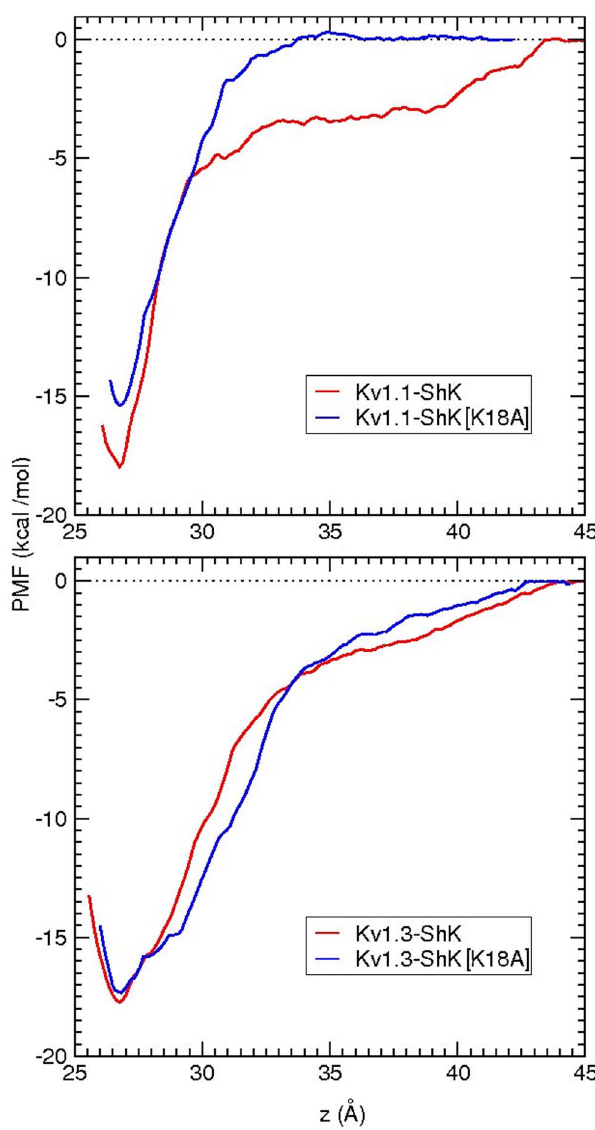
Figure 4. Comparison of the PMFs for the unbinding of ShK and ShK[K18A] from the Kv1.1 and Kv1.3